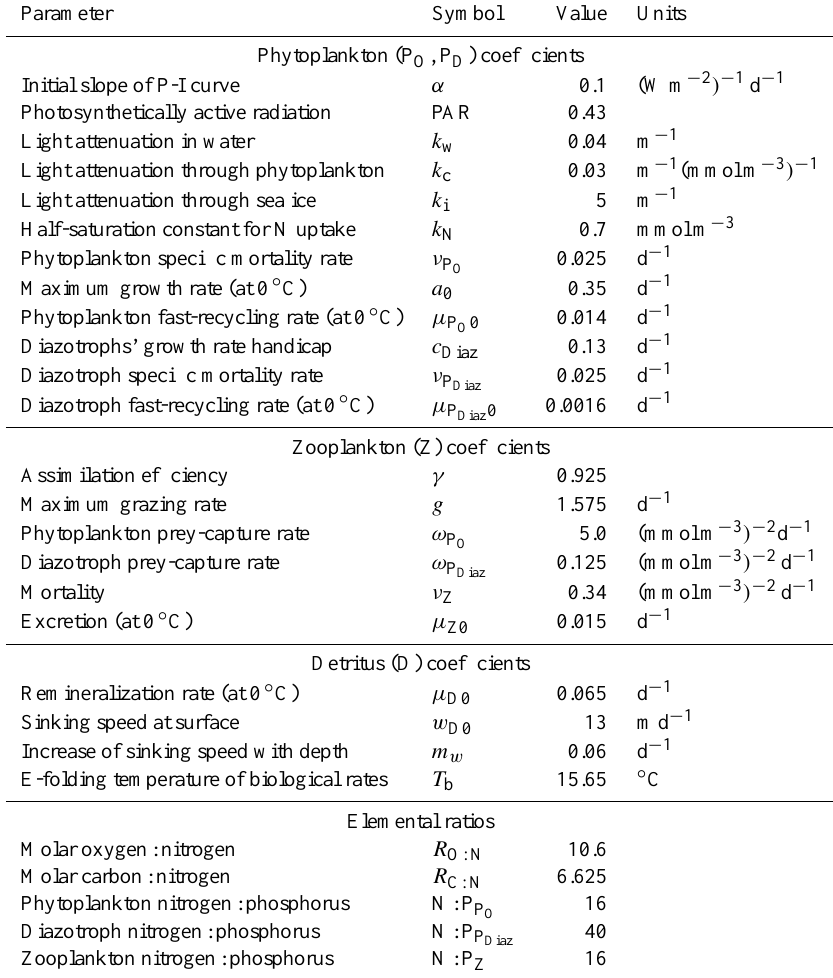
Table B1. Marine ecosystem-biogeochemical parameter list ∗ . Parameter